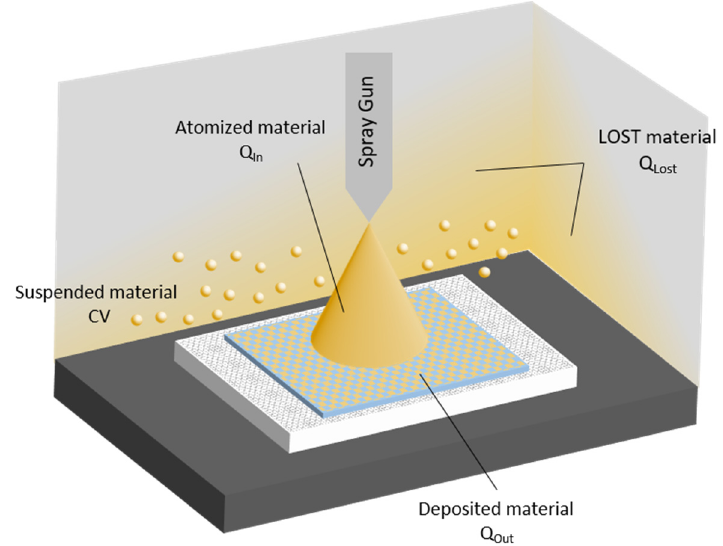
Figure 9. Scheme of the mass balance inside the spray chamber. Table 4. Atomised suspension, deposited and lost materials, aerosol concentration and deposition efficiency (E) for each run.